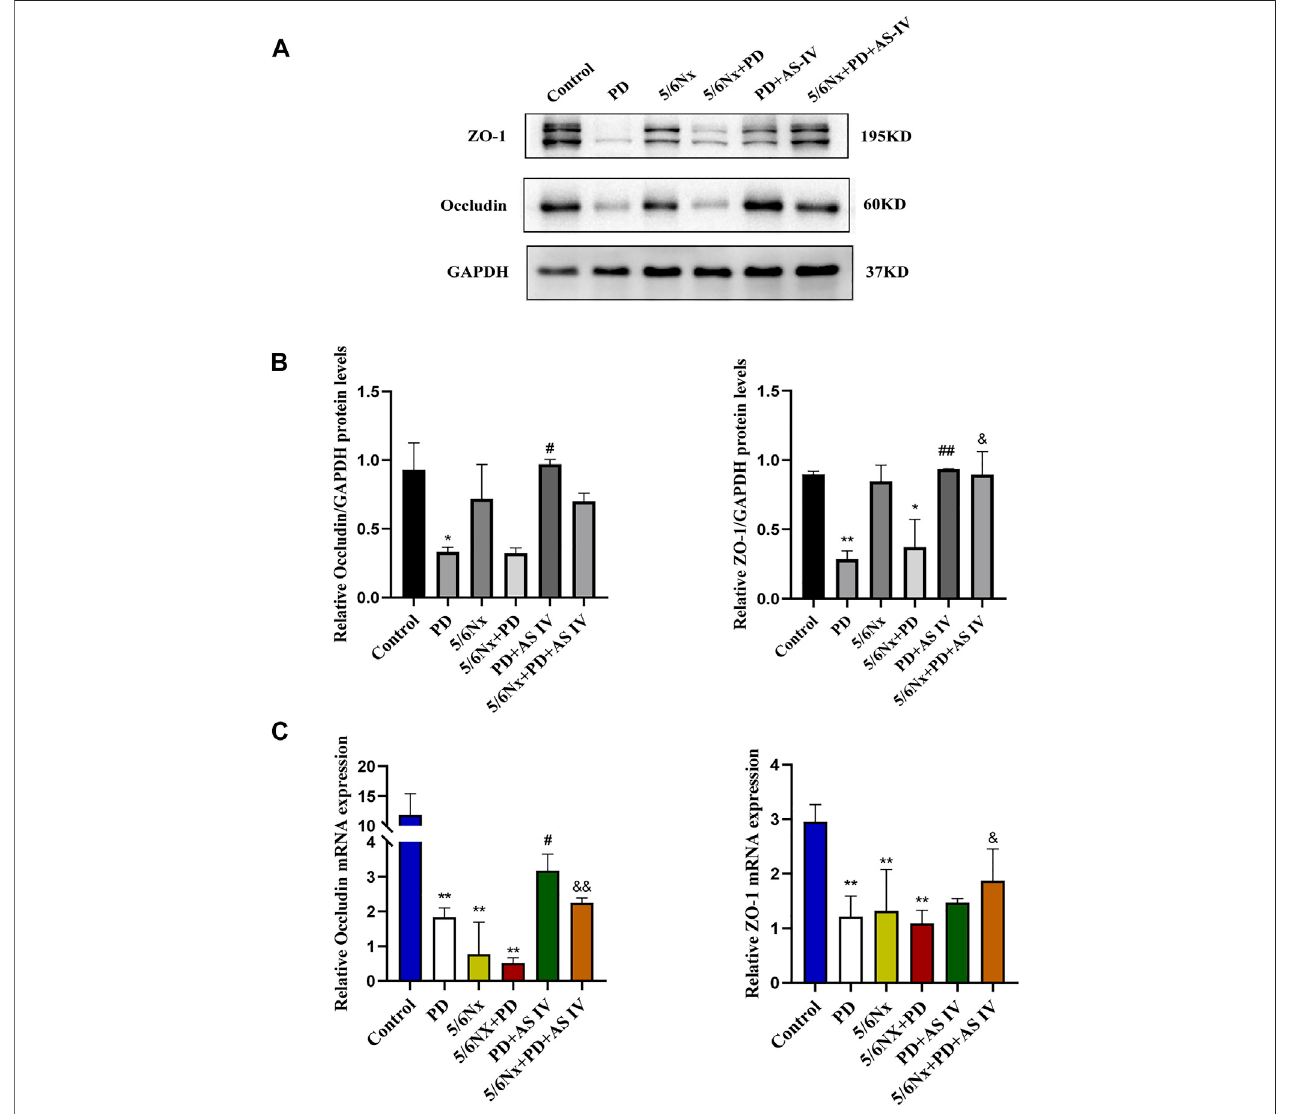
FIGURE 2 | Effects of AS IV on the expression of tight junction proteins in mice exposed to PDF (A,B) The protein expression levels of occludin and ZO-1 determinedbywesternblottinganalysis (C) ThemRNAexpressionlevelsofoccludinandZO-1weredeterminedbyReal-timePCR.Dataarepresentedasmeans±SDof threeindependentexperiments.* p < 0.05or** p < 0.01versusthecontrolgroup. # p < 0.05or ## p < 0.01versusthePDgroup. & p < 0.05or && p < 0.01versusthe5/6Nx+ PD